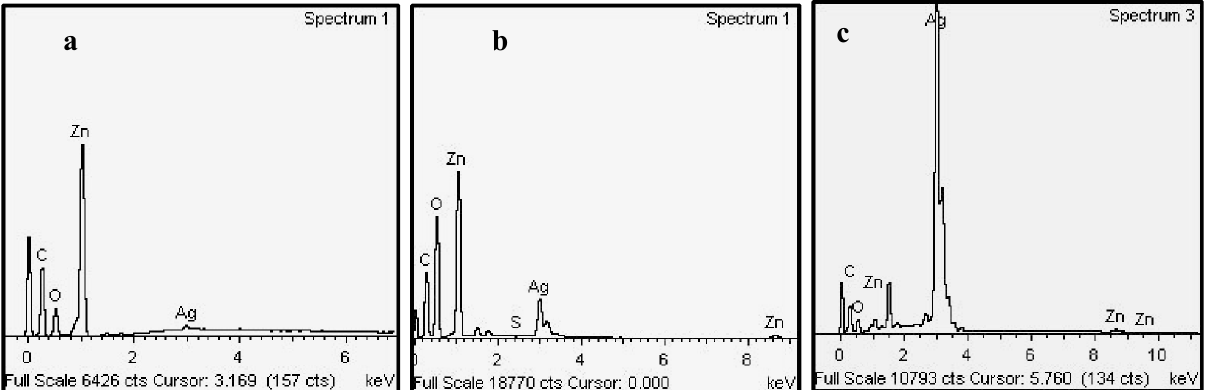
Figure 3. EDS spectra of 5.0 wt% ZnO-Ag nanoparticles at circles marked ( a ) A. ( b ) B. and ( c ) C from Figure